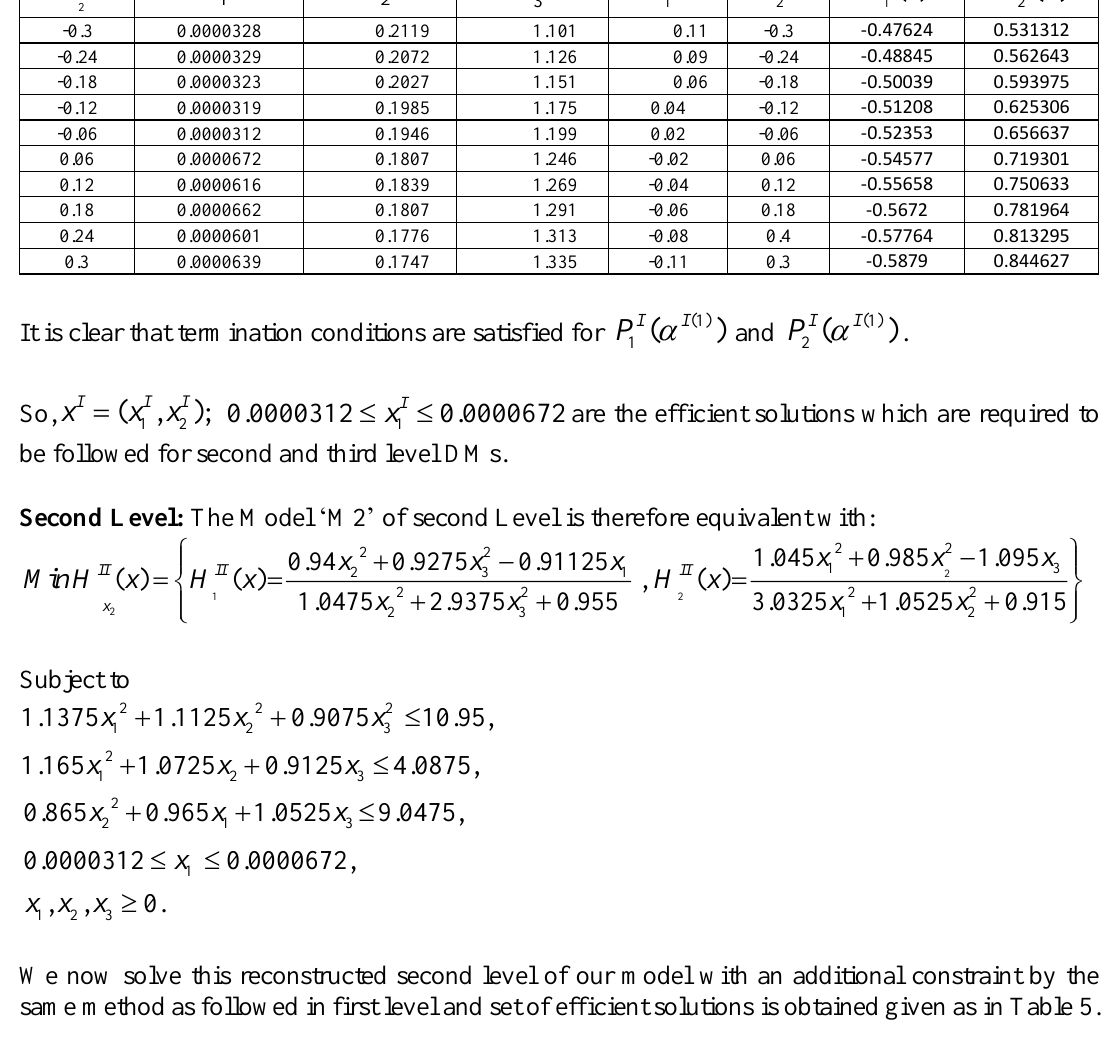
Table 5. Efficient solutions for the second